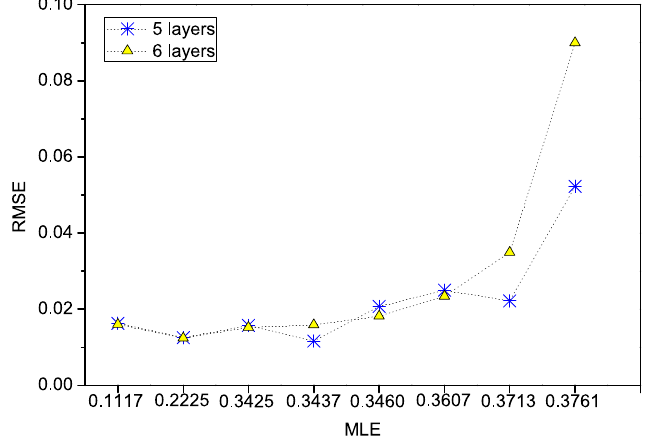
Figure 6. Comparing the RMSE of the MLPs with five and six layers from Table 3 for the prediction of the chaotic time series listed in Table 1 and achieving a twelve steps-ahead prediction horizon.